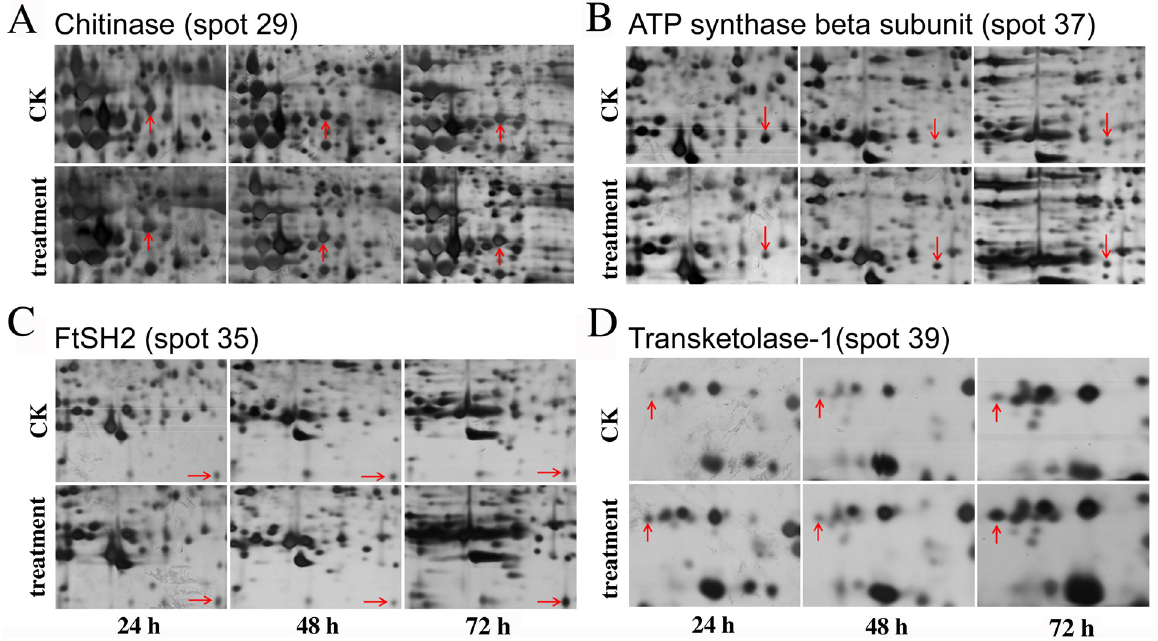
Fig 5. Dynamic patterns of randomly selected salt-responsive proteins at 24 h, 48 h, and 72 h after 200 mM NaCl treatment on B . napus ‘ Nannongyou No. 3 ’